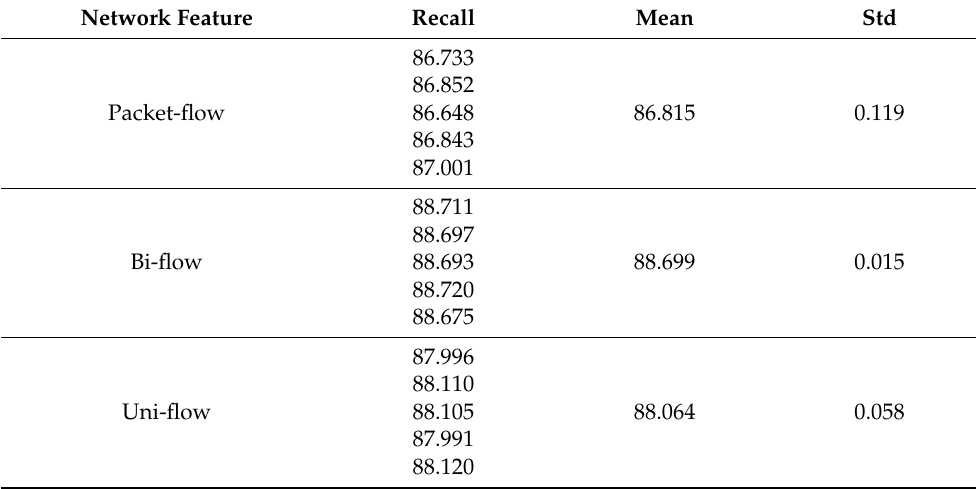
Table 12. Binary-class attack classification results in terms of recall.